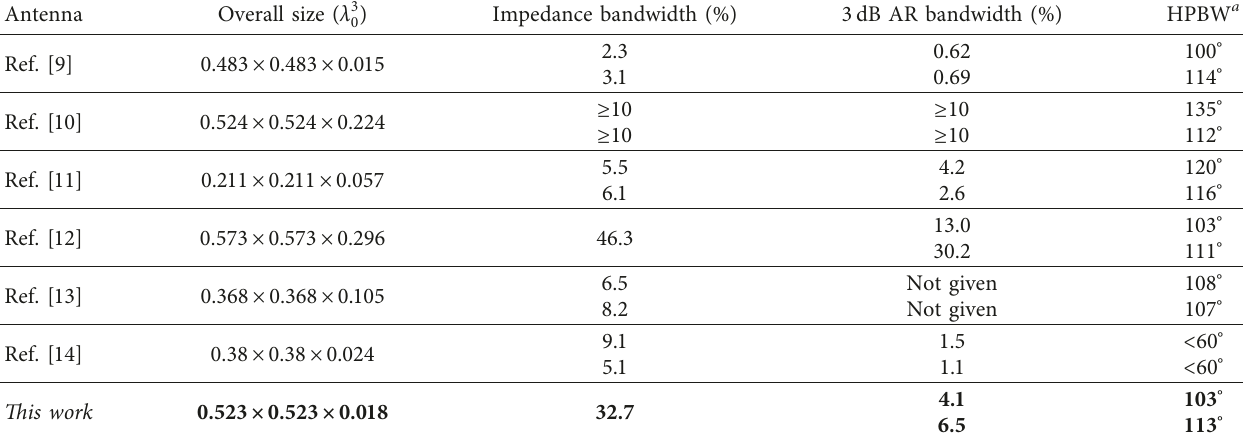
Table 2: Comparisons between our design and previous dual-band CP antennas.